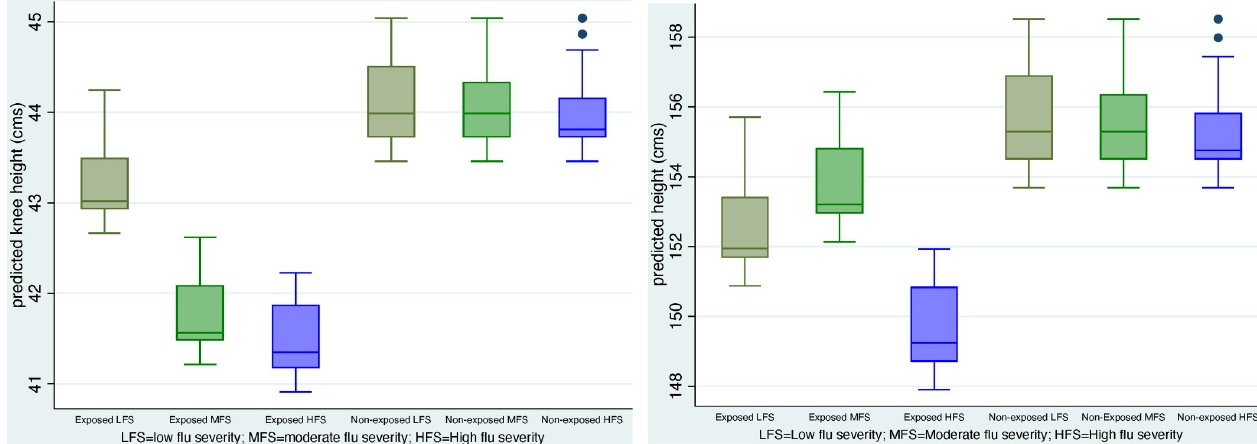
Fig 3. A. Box plots of predicted values of knee height. (Models including flu severity-female sample). B. Box plots of predicted values of height. (Models including flu severity-female sample).